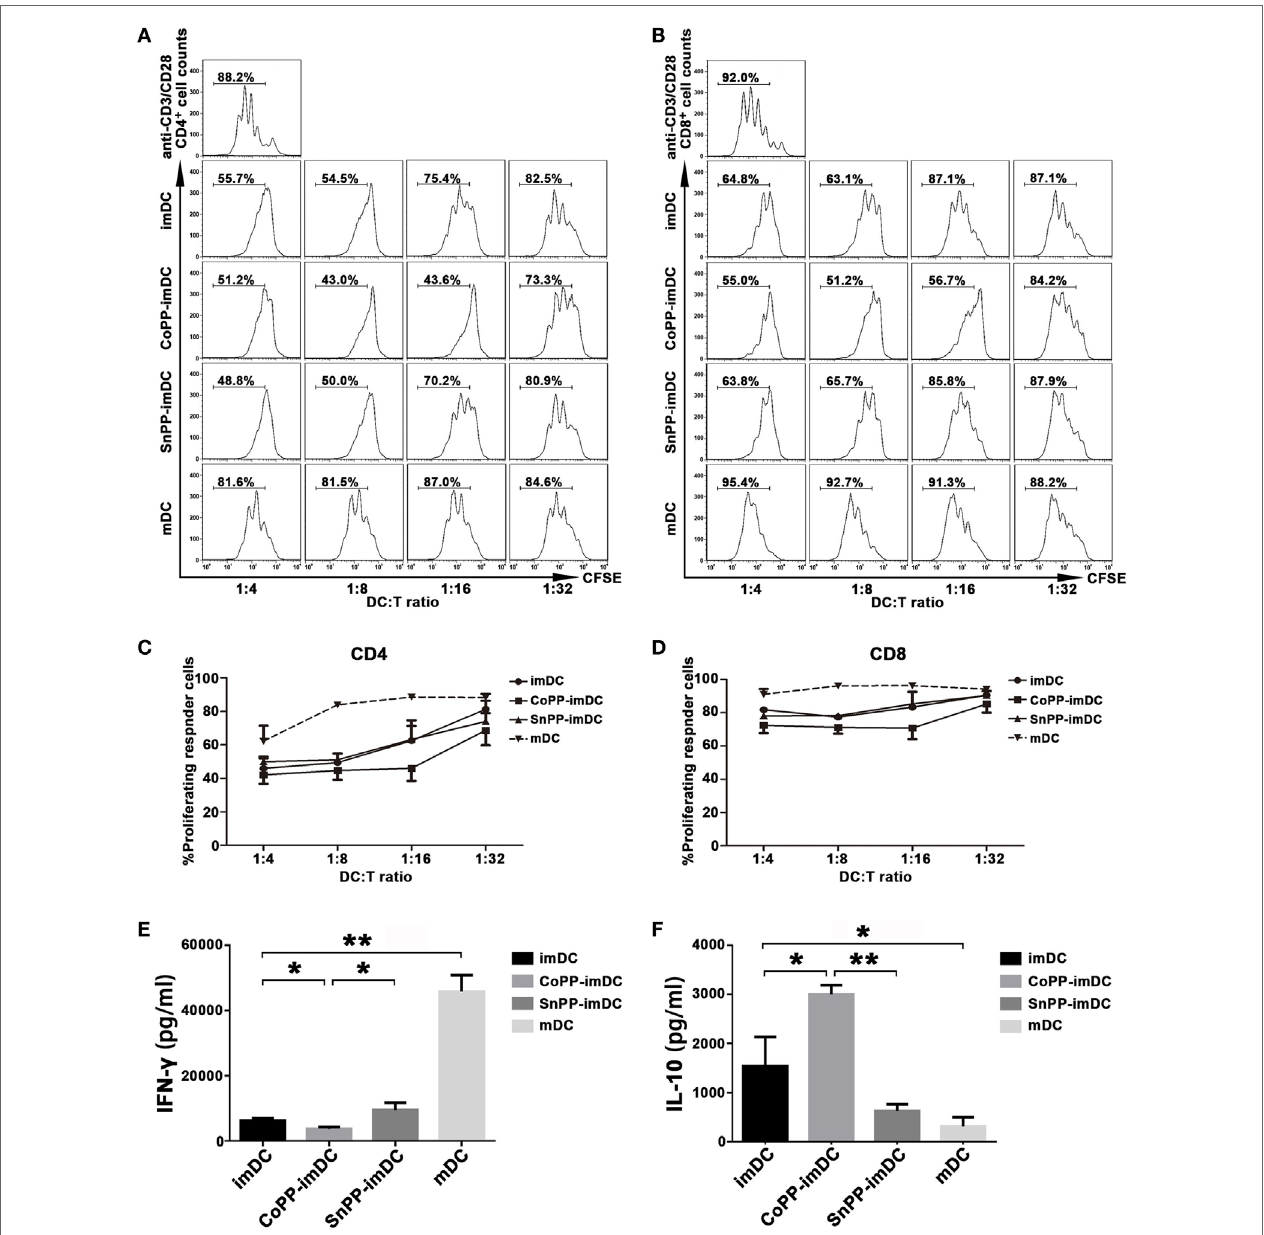
FigUre 3 | Upregulation of heme oxygenase-1 enhances the ability of immature dendritic cells (imDCs) to inhibit allogeneic T-cell proliferation stimulated by anti-CD3/CD28 Abs. CFSE-labeled lymphocytes from C57BL/6 mice were stimulated with anti-CD3 ε and anti-CD28 Abs (2 µg/ml) to achieve profound cell proliferation. Graded doses of untreated imDCs, cobalt protoporphyrin-pretreated imDCs, SnPP-pretreated imDCs, or mDCs from BALB/c mice were added to the lymphocyte stimulation system at different ratios (1:4, 1:8, 1:16, and 1:32). Three days later, CD4 + and CD8 + T-cell proliferation was separately evaluated by FACS analysis. (a,B) Representative FACS results of three independent experiments for CD4 + (a) and CD8 + (B) T-cell proliferation. Numbers within the graph denote the percentage of proliferated cells. (c,D) The average percentages of proliferated CD4 + (c) and CD8 + (D) T cells. Data are shown as mean ± SD ( n = 3 per group). (e,F) Supernatants were collected after 48 h from the lymphocyte stimulation system at a DC/T cell ratio of 1:16 and analyzed by ELISA to determine the levels of IFN- γ (e) and IL-10 (F) . Data are shown as means ± SD ( n = 3 per group, * P < 0.05, ** P <